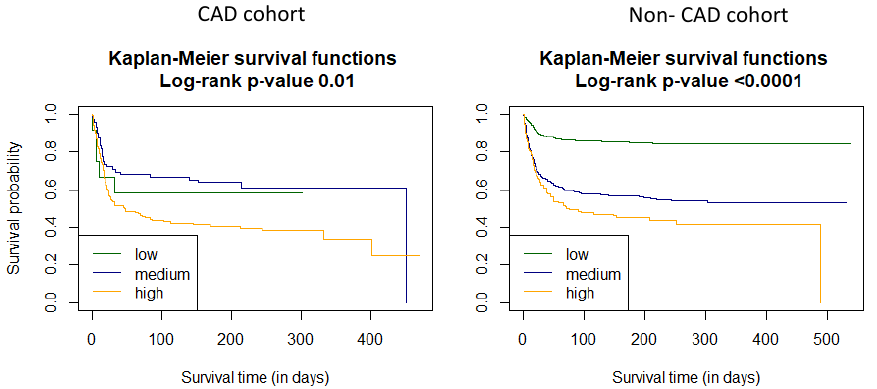
Figure 2. Time-dependent ROC analysis for the C 2 HEST predictive abilities of all-cause death in both study cohorts.